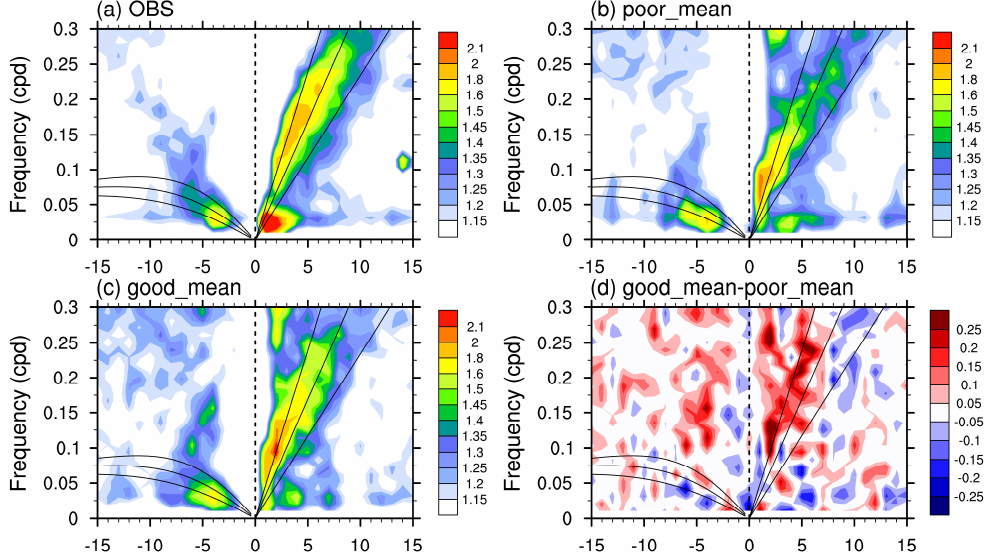
Figure 7. Boreal-winter (November–April) Signal-to-noise ratio in the wavenumber–frequency spectral domain of the 15° S–15° N symmetric components of OLR anomalies in ( a ) observation, ( b ) composite of poor simulations, ( c ) composite of good simulations and ( d ) difference between composited results of good and poor simulations.